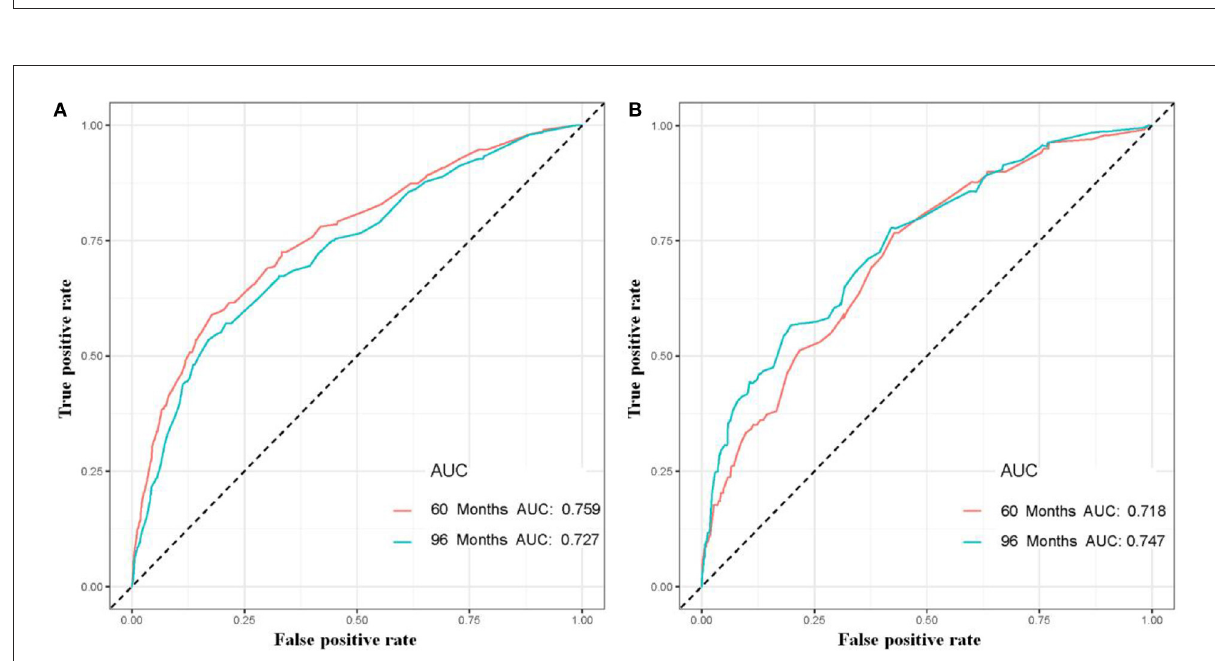
FIGURE4 The 5- and 8-year receiver operating characteristic curves of older female primary breast cancer patients that underwent chemotherapy in the training (A) and validation (B) cohorts.